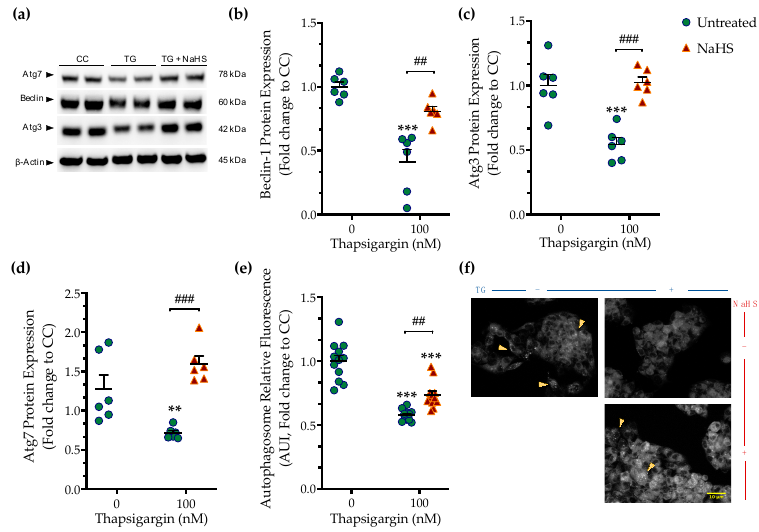
Figure 5. NaHS co-treatment rescues the arrested autophagy following chronic ER stress. HepG2 cells were serum-starved for 8 h and treated with the vehicle or 100 nM of thapsigargin (TG), in the presence or absence of 100 µM NaHS for 16 h. Cells were harvested, and the extracted protein was processed for Western blotting analysis of the expression levels of beclin-1 ( a , b ), Atg3 ( a , c ), and Atg7 ( a , d ). Alternatively, cells were incubated with the Autophagosome Detection Reagent working solution for 30 min at 37 °C with a humidified incubator with 5% CO 2 and 95% air. Cells were washed thrice and the fluorescence signal was read with an Infinite ® 200 PRO microplate reader ( e ). Representative images of the labeling were captured under an Olympus CKX53 inverted fluorescent microscope with a DAPI channel ( f ). Autophagy is indicated by bright dot staining of the autophagic vacuoles (yellow arrowheads). Data are expressed as a fold change of the control (vehicle-treated) conditions (CC). ** p ≤ 0.01, *** p ≤ 0.001 compared to CC; ## p ≤ 0.01, ### p ≤ 0.001 compared to TG-treated cells. For the abbreviations used, please refer to the main text. Scale bar: 10 µ